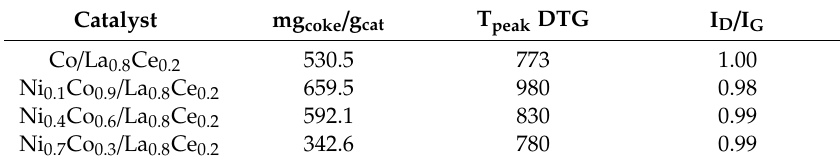
Table 3. Carbon deposition on Ni x Co 1-x /La 0.8 Ce 0.2 catalysts evaluated by TGA.